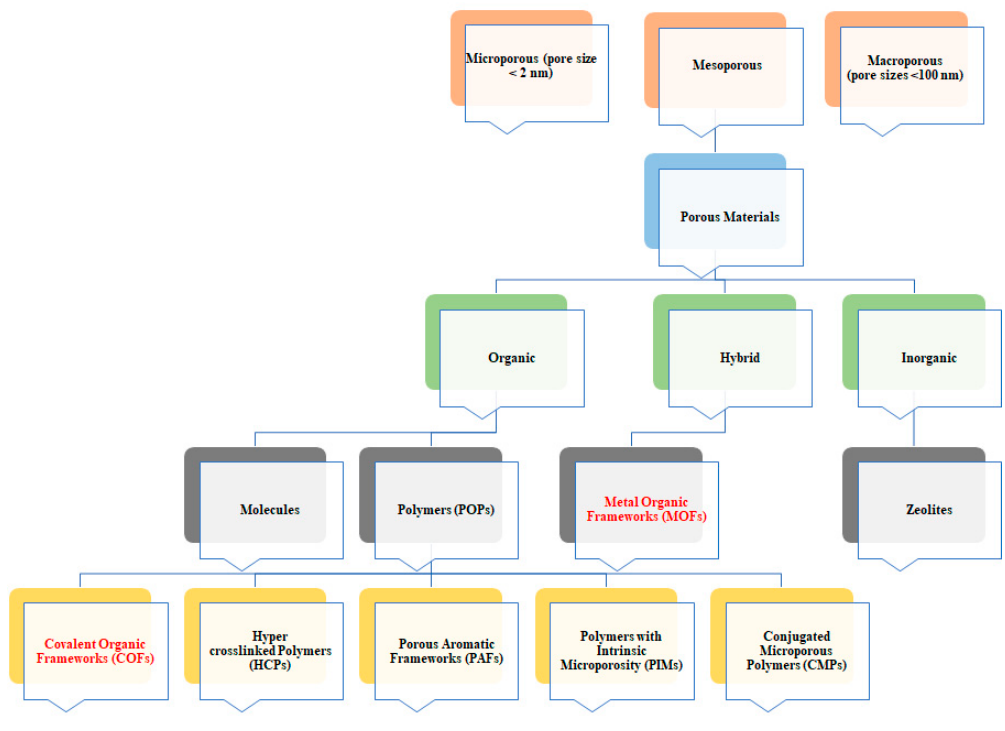
Figure 1. Categorization of porous materials based on their pore size and the material varieties.